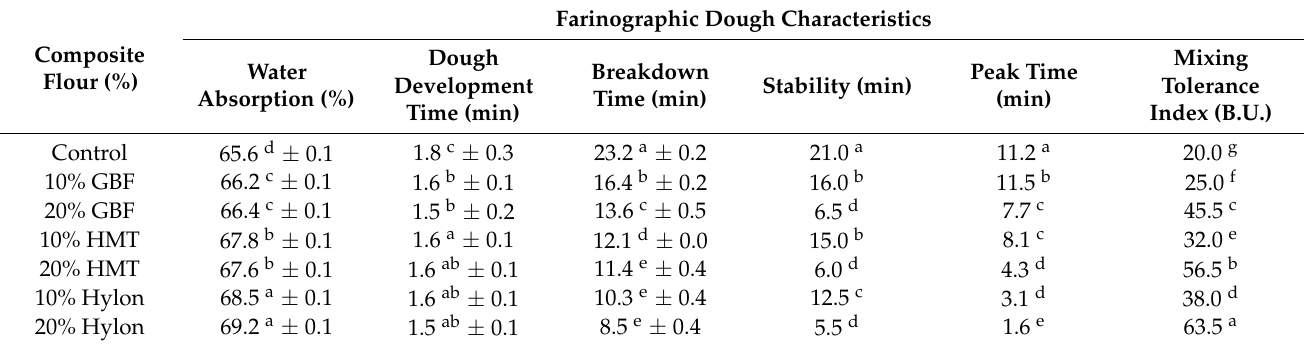
Table 1. Farinograph analysis of wheat flour dough containing different resistant starch source